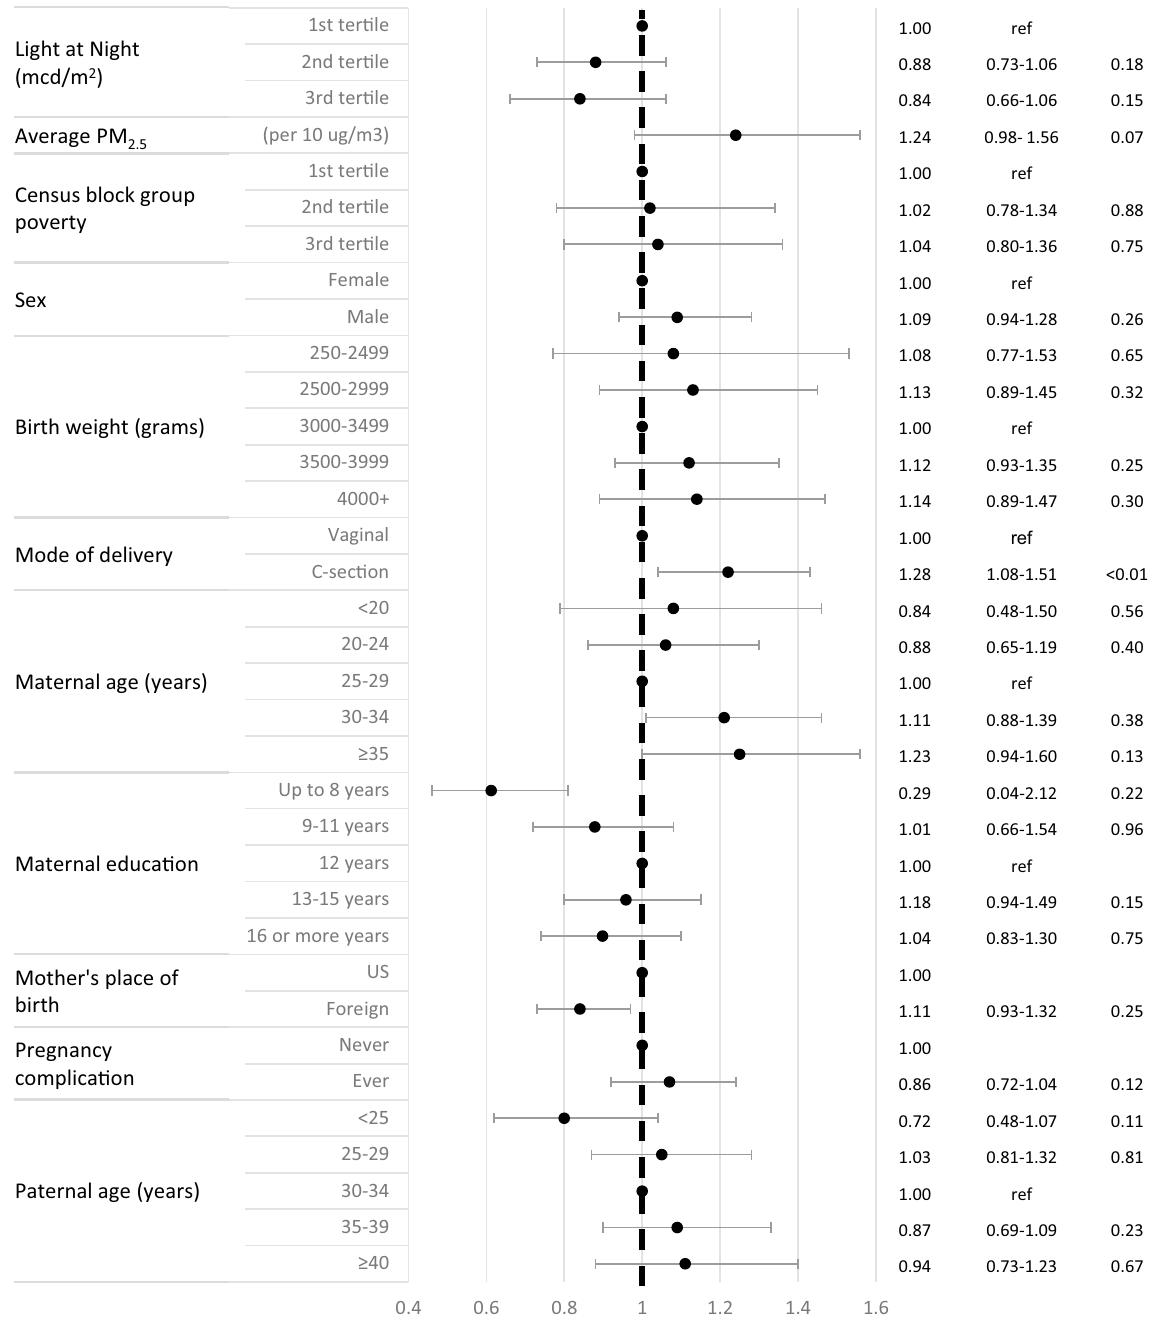
Figure 2. Association between outdoor artificial light at night, air pollution, birth characteristics, and risk of childhood acute lymphoblastic leukemia among Non-Hispanic White children in the California Linkage Study of Early-Onset Cancers. *Adjusted odds ratios and 95% confidence intervals were derived from a multivariable logistic regression model that simultaneously included all variables listed in this